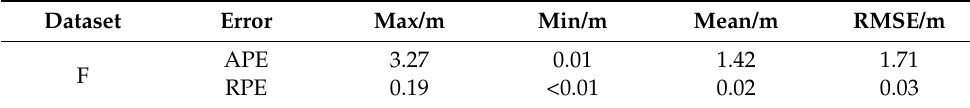
Table 3. Absolute pose error and relative pose error.